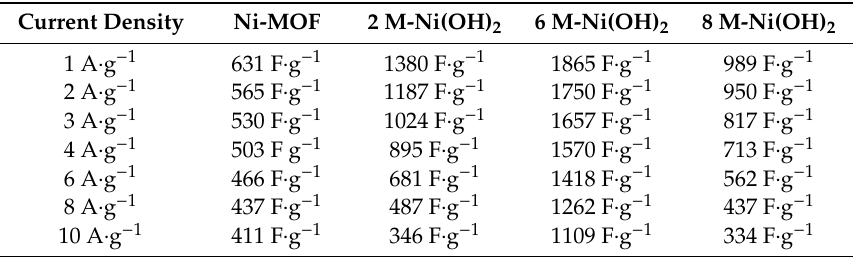
Table 4. Specific capacitance values of the four samples at di ff erent current